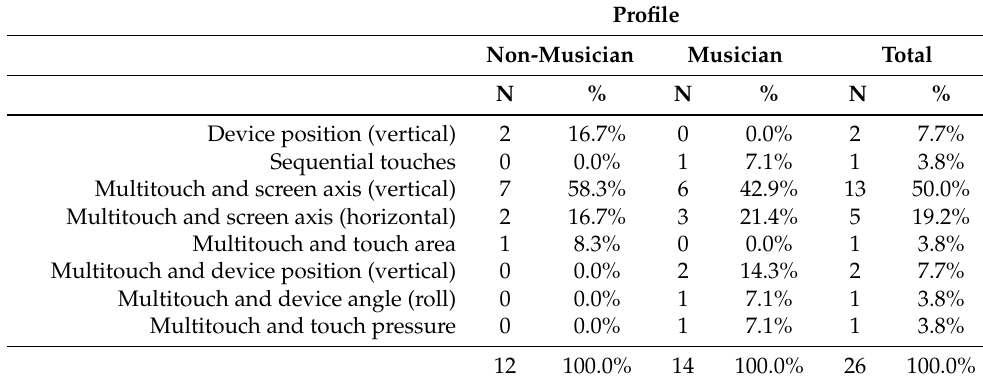
Table A16. Polyphony mapping (uncategorized)—stimulus e.